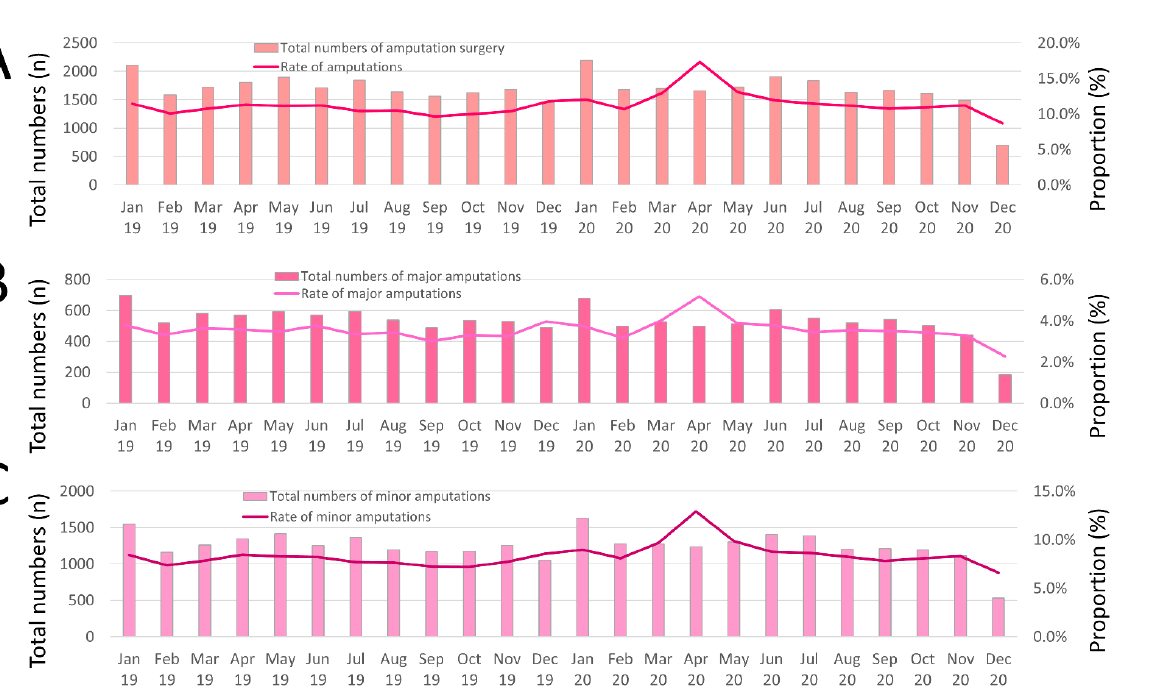
PAD patients with revascularization treatments (blue bars), and proportion of revascularization treatment related to all hospitalizations of PAD patients (grey line) stratified for treatment month. ( B ) Temporal trends regarding absolute numbers of hospitalizations of PAD patients with peripheral endovascular intervention at the lower extremities (dark blue bars), and proportion of peripheral endovascular intervention at the lower extremities related to all hospitalizations of PAD patients (grey line) stratified for treatment month. ( C ) Temporal trends regarding absolute numbers of hospitalizations of PAD patients with peripheral artery bypass operations (light blue bars), and proportion of peripheral artery bypass operations treatment related to all hospitalizations of PAD patients (grey line) stratified for treatment month.